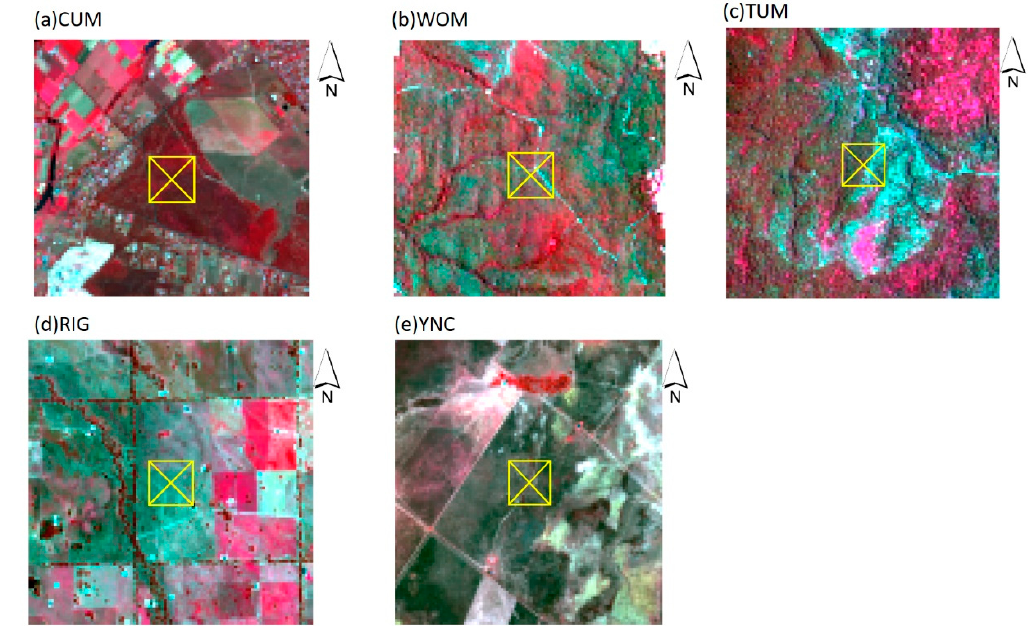
Figure 1. False-color composite images of the study area at each site (band 8 for the red channel, band 4 for the green channel, and band 3 for the blue channel) in January 2018. The region in each subfigure is a 3 × 3-km footprint range. The yellow box in the middle of the image is the carbon flux footprint region. CUM—Cumberland Plain; WOM—Wombat Forest; TUM—Tumbarumba; RIG—Riggs Creek; YNC—Yanco.